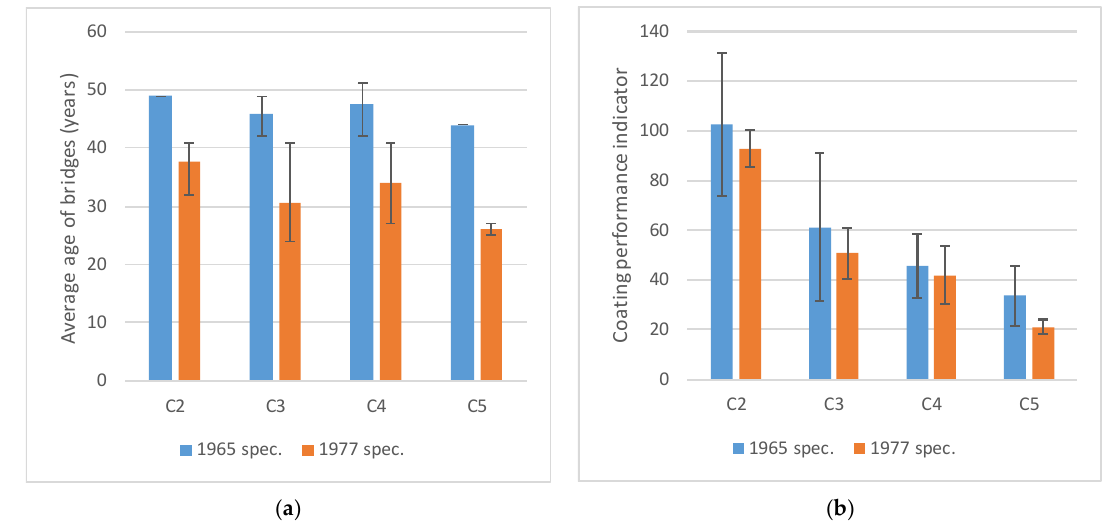
Figure 4. The coating age and performance: ( a ) Average age of the bridges. The bars show the highest and lowest age within each category of corrosivity; ( b ) Coating performance indicator as a function of corrosivity. The bars indicate standard deviation.